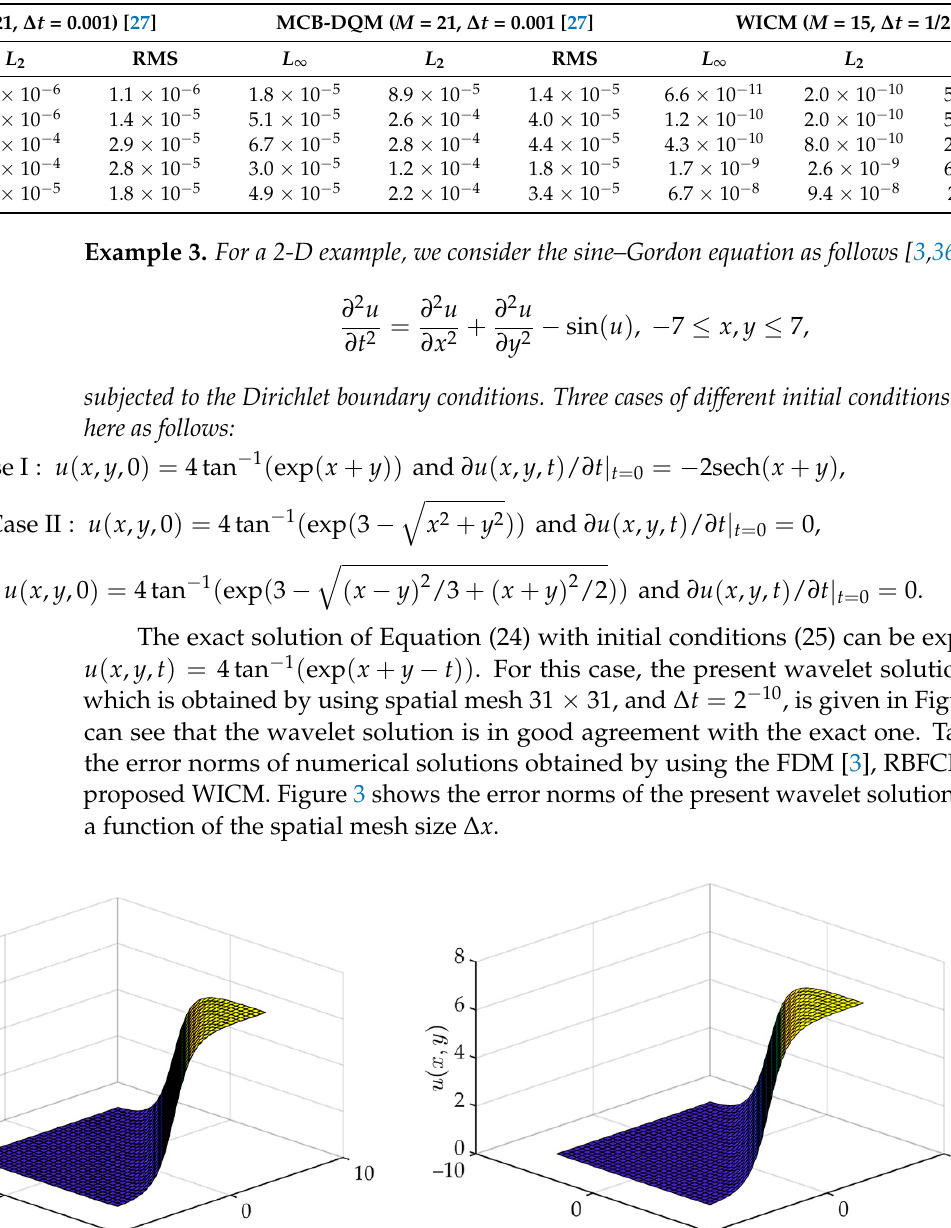
Figure 2. Exact solution ( Left ) and wavelet solution ( Right ) using spatial mesh 31 × 31 and time step ∆ t = 2 − 10 at t = 1 for Case I of Example 3. Table 5. Error norms of numerical solutions at different time t for Case I of Example 3.